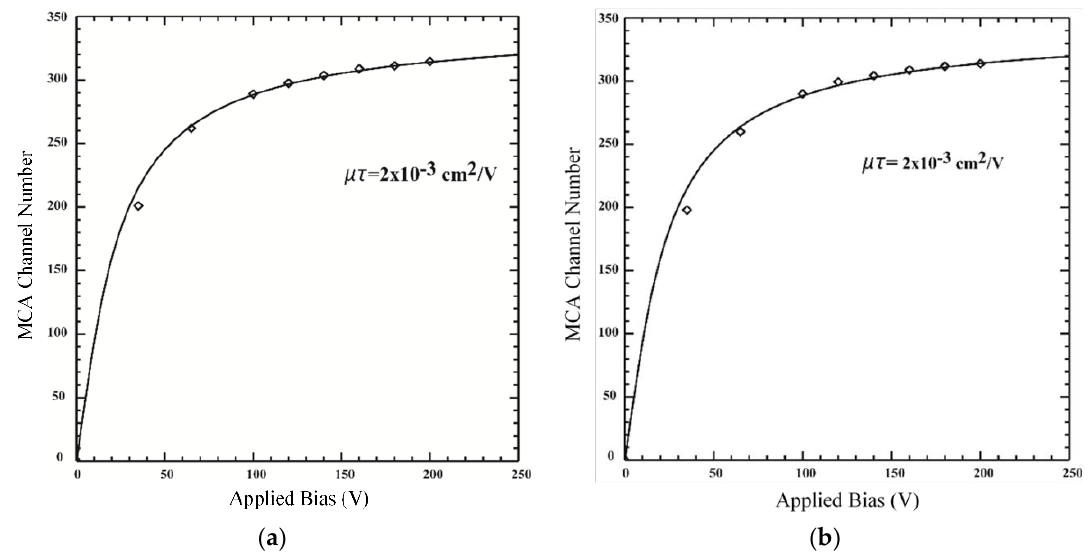
Figure 5. The plots of MCA channel number at various applied voltages: ( a ) Before passivation in NH 4 F solution, ( b ) after passivation in NH 4 F solution.